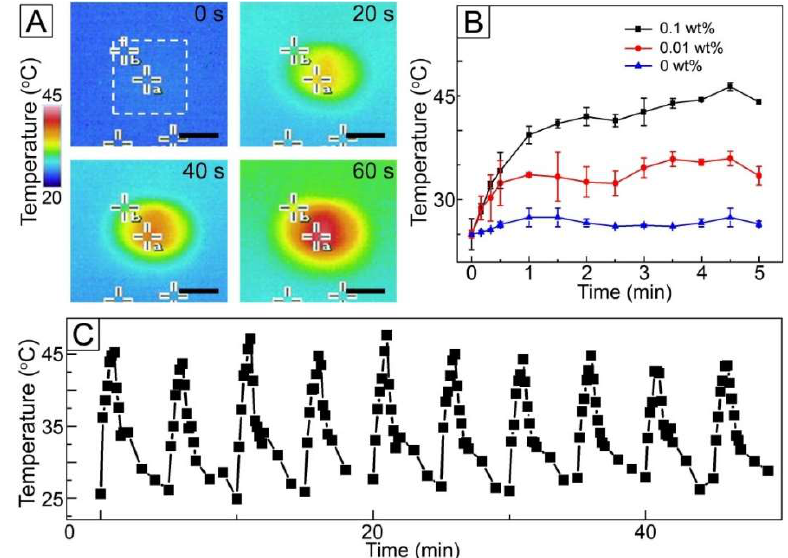
Figure 4. ( A ) Time-lapse thermal infrared images of AuNC-loaded fibers under NIR light irradiation (1 W/cm 2 , 808 nm). The scale bar is 0.5 cm. ( B ) Change in temperature for the fibers, which were produced from the W/O emulsions with different concentration of AuNCs, under NIR light (1 W/cm 2 , 808 nm). ( C ) Time-dependent temperature curve for AuNC-loaded fibers under on–off switching of NIR light (1 W/cm 2 , 808 nm).